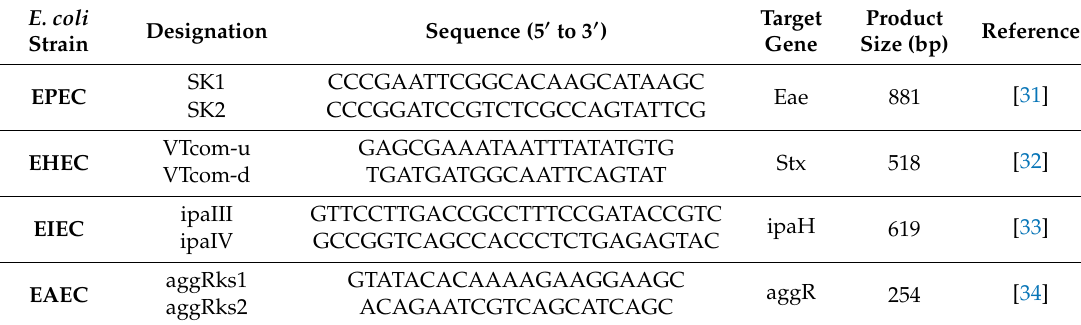
Table 1. Species-specific primers used for the identification of diarrhoeagenic E. coli